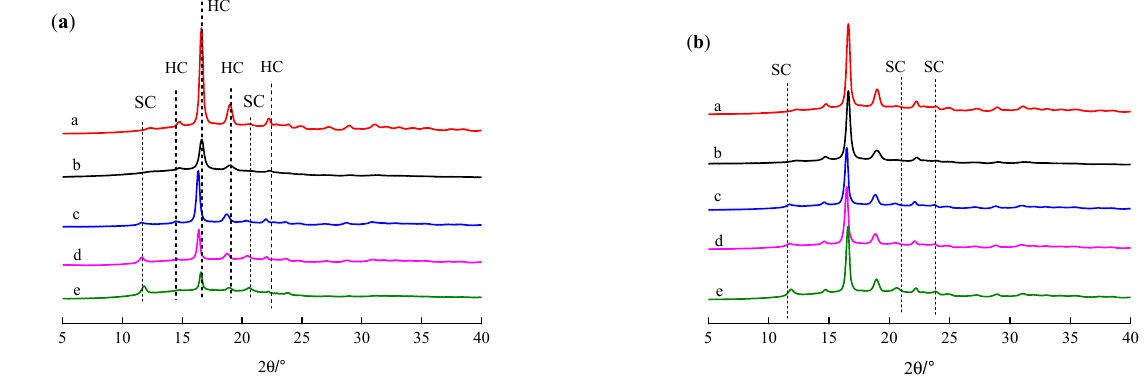
Figure 5. XRD curve of PLLA, PDLA, PDLAG, m-PLLA and m-PLAG samples. ( a ) a. PLLA; b. PDLA; c. m-PLLA-1; d. m-PLLA-2; e. m-PLLA-3; ( b ) a. PLLA; b. PDLAG; c. m-PLAG-1; d. m-PLAG-2; e. m-PLAG-3.